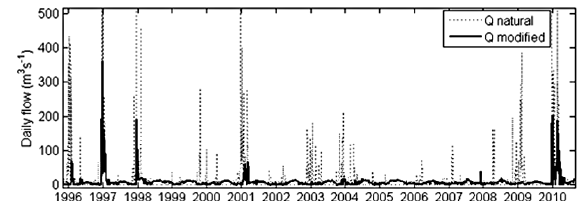
Figure 3. Detail of the period under current regulation level: aver- age daily flow observed (modified regime; thick line) and restored (natural regime; dot line) in the final stretch of the Guadalete River downstream of the confluence of the two main channels.